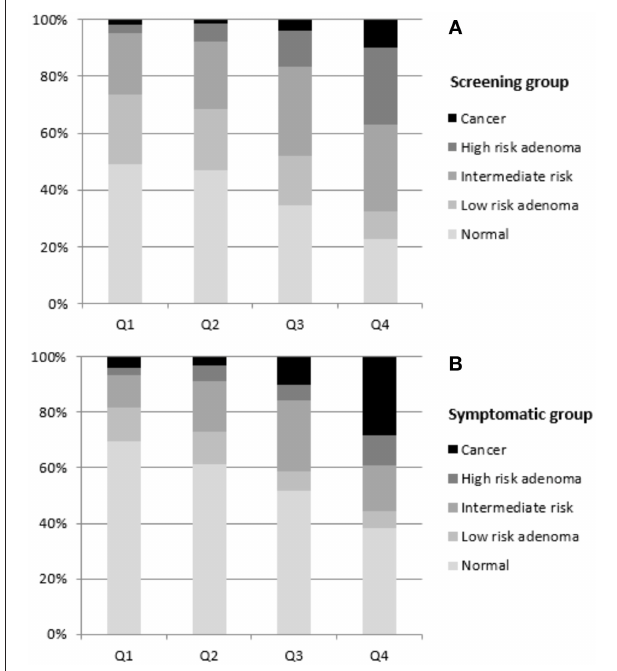
FIGURE 1 | Colonoscopy findings according to Hb quartile in (A) screening group ( p < 0.001) and in (B) symptomatic group ( p < 0.001).